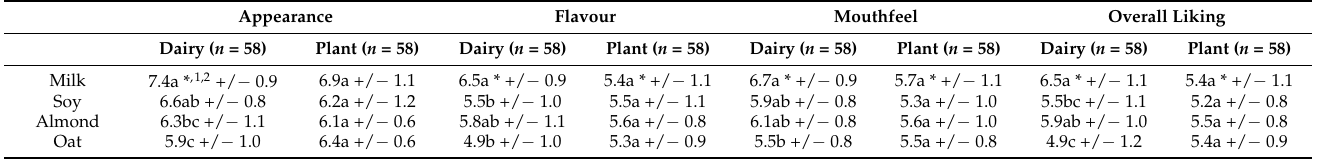
Table 4. Consumer mean liking scores (+/ − standard deviation) for the different coffee samples separated into different consumption